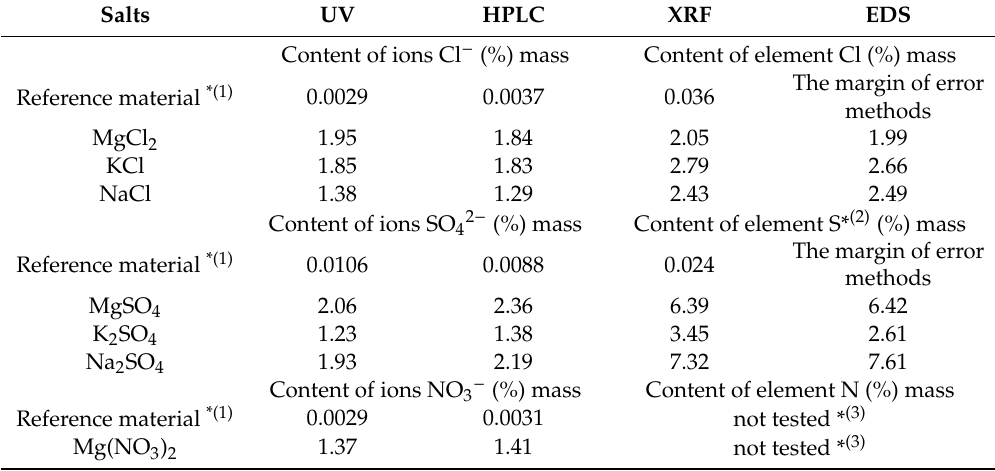
Table 1. Results of tests for the content of selected ions and elements determined by di ff erent test methods.